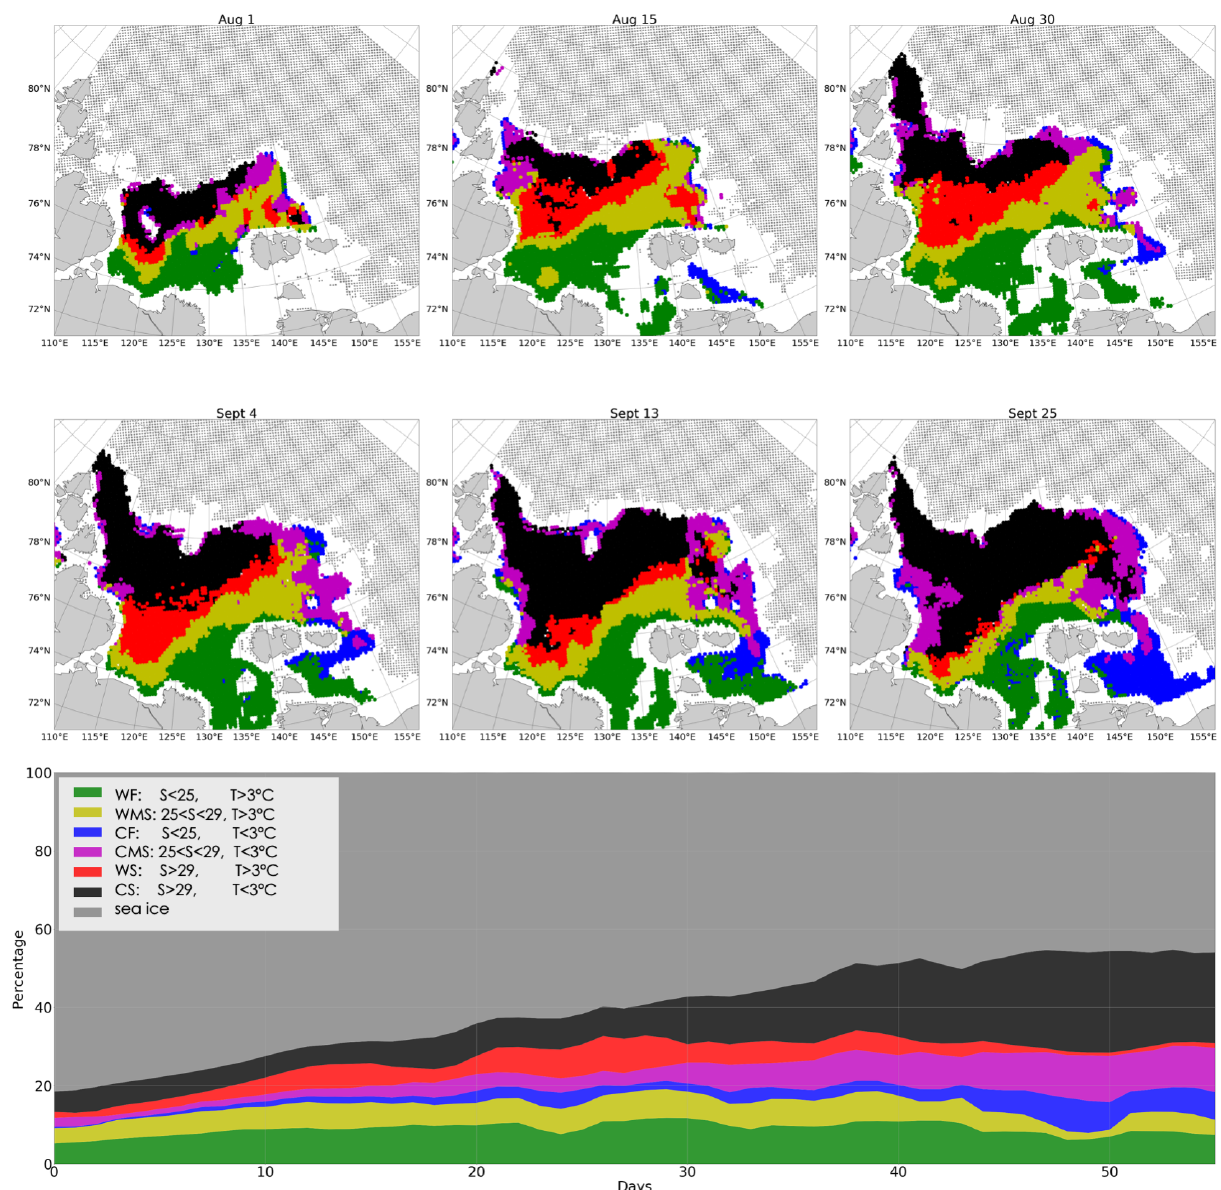
Figure 9. Spatial distribution of surface water masses in August–September 2018. The upper row shows 1, 15, 30 August, and the middle row shows 4, 13, 30 September. Sea ice cover from AMSR2 is plotted as the dashed area. The lowest panel shows the temporal evolution of surfaces occupied by each water mass or sea ice cover in the Laptev Sea (in percentage of the Laptev Sea